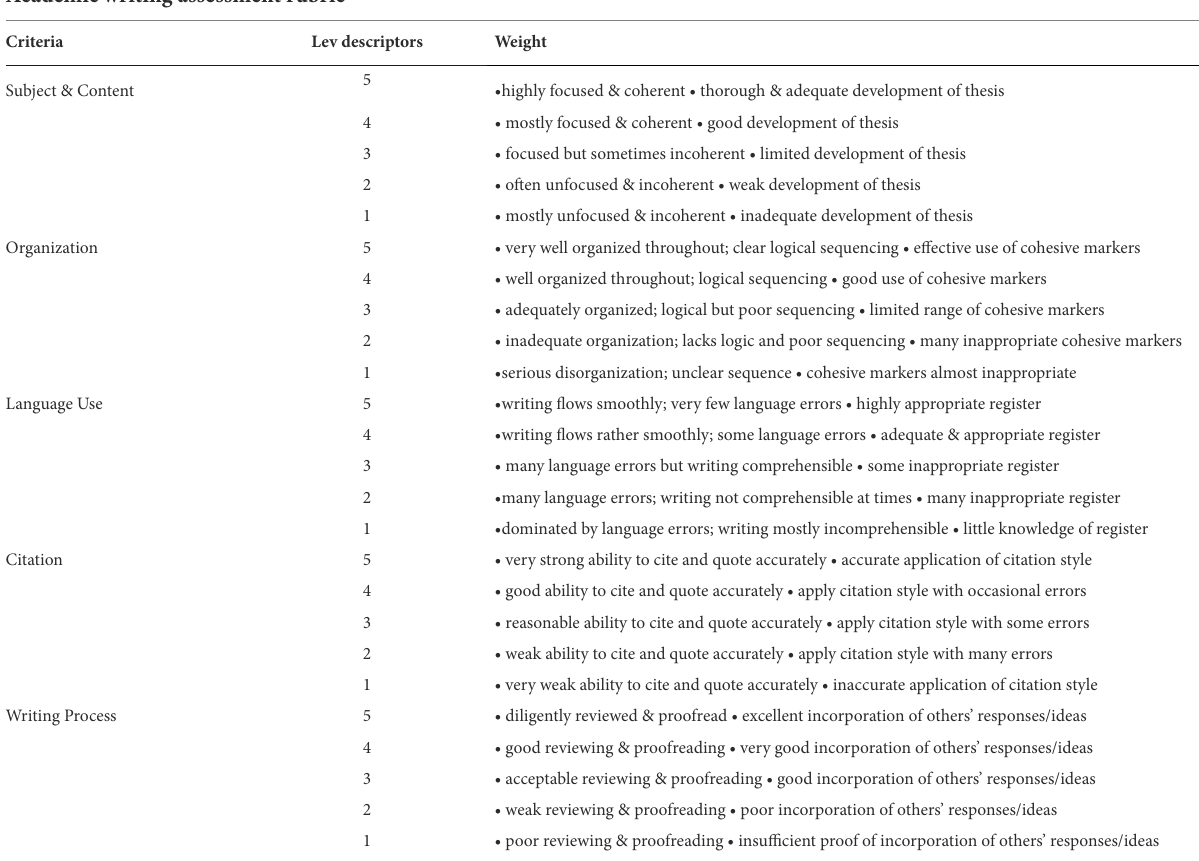
TABLE 1 Subsections and levels of the rubric used in the